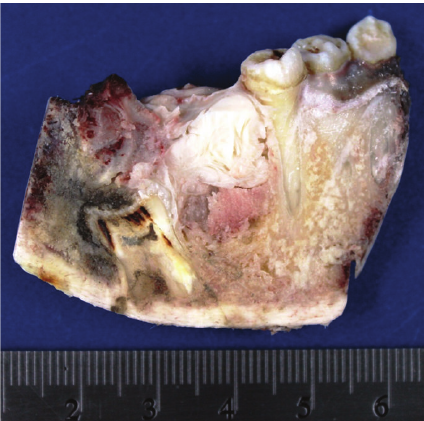
Figure 5: Gross photograph of the cut surface of the left half of the mandible showing a solid gray tumor mass.